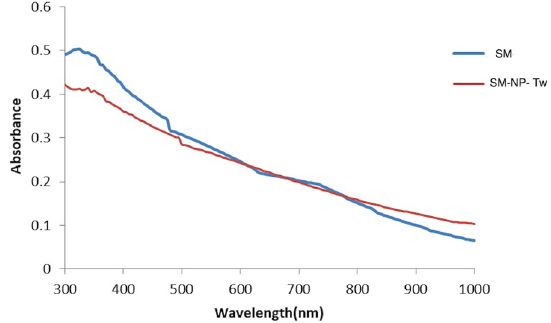
Fig. 6 UV–Visible spectra of Sepia melanin alkaline aqueous solution pH 12 (SM) and self-assembled tween-based nanoparticles (SM-NP-Tw)